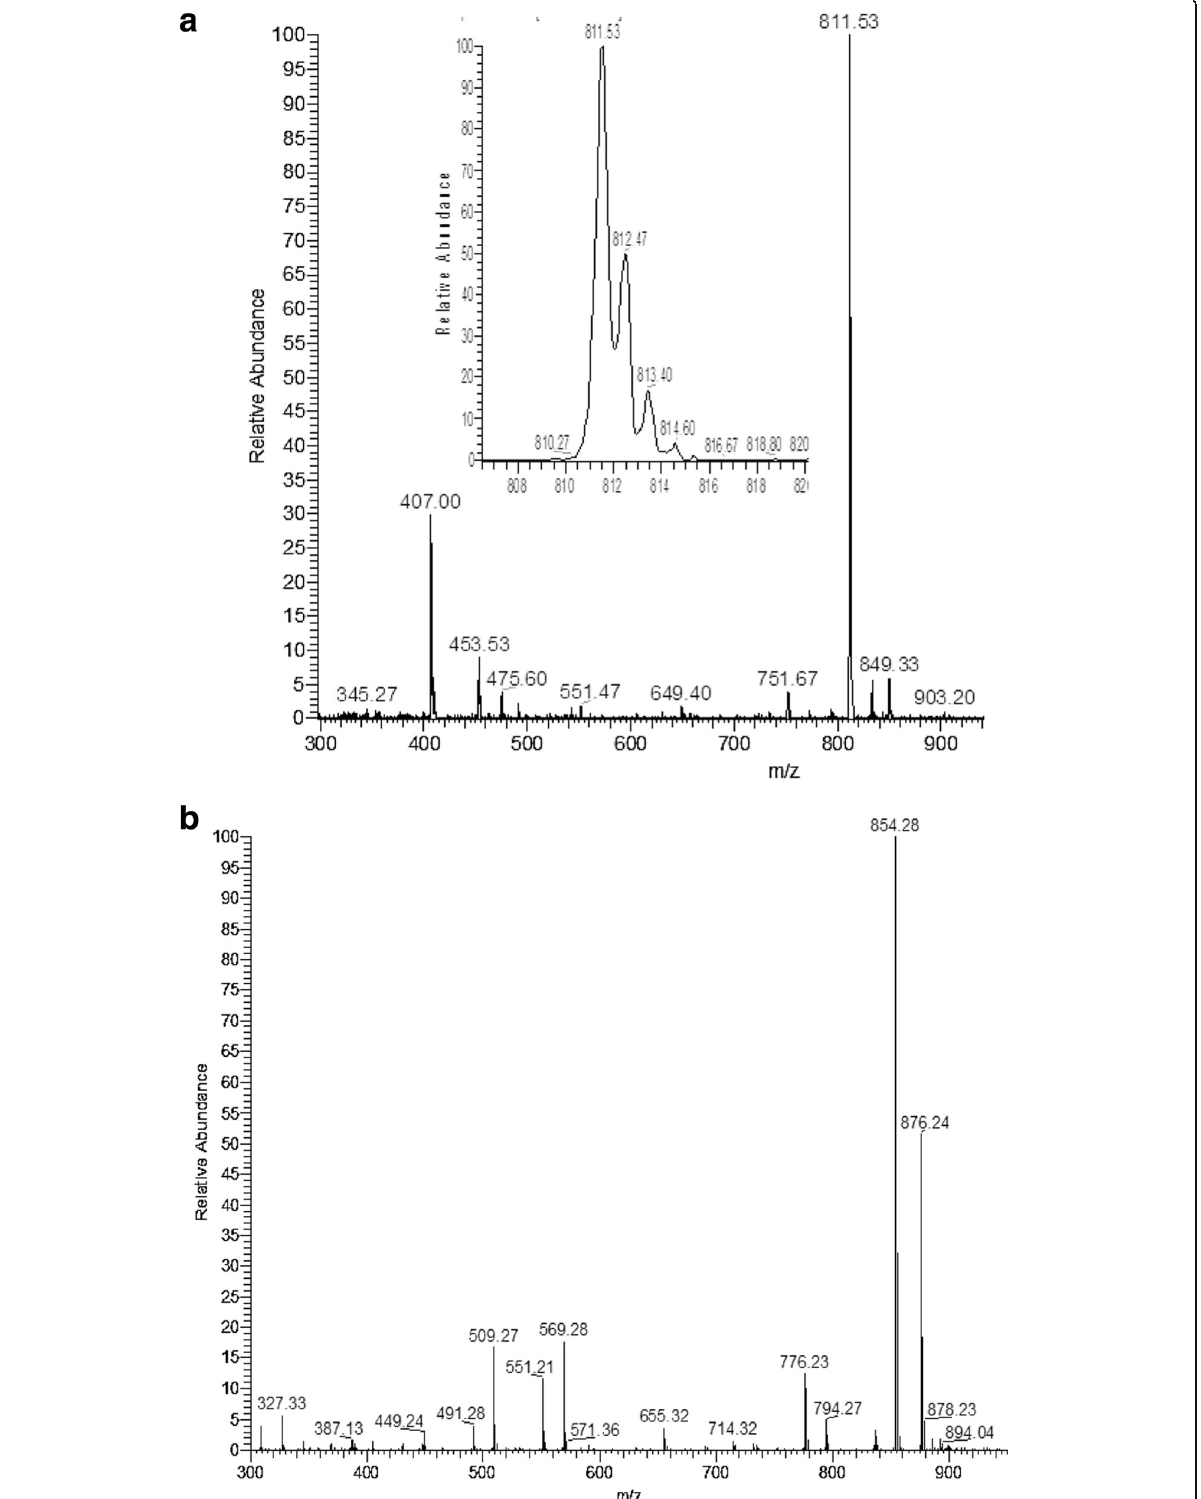
Fig. 4 ESI-MS analysis of fungal EDT ( a ) MS- ESI spectrum of fungal EDT showing [M + H] + m/z of 811.53, ( b ) ESI- MS spectrum of Paclitaxel showing [M + H] + m/z of